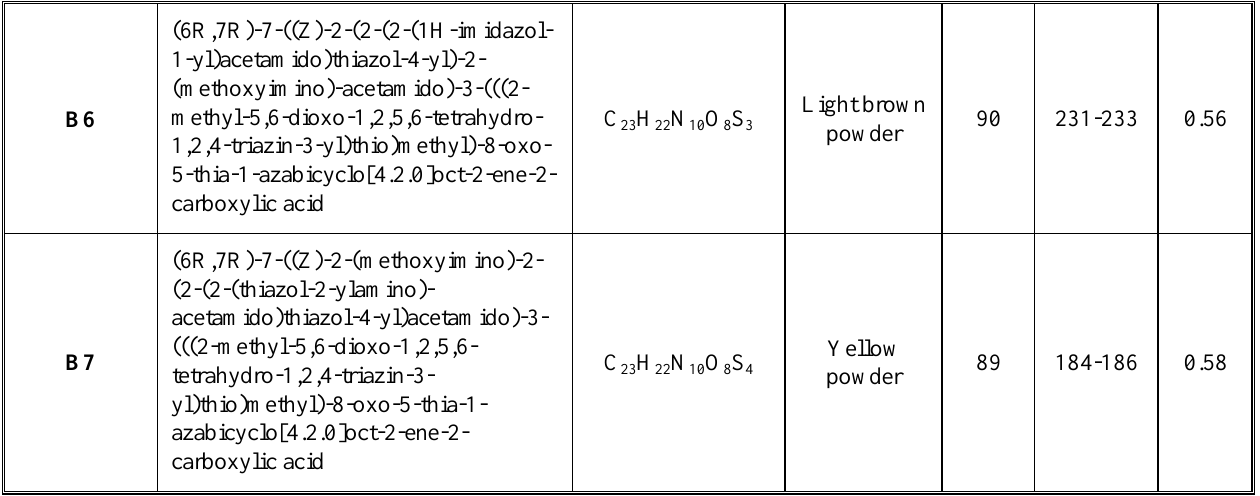
Table (2): The elemental microanalysis (CHNS) of the synthesized intermediate (A) and target compounds (B1-B7)